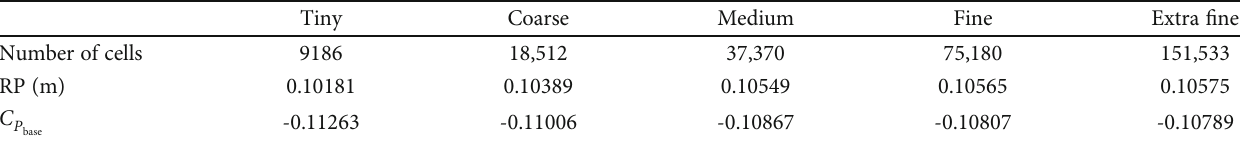
Table 4: Grid sensitivity test (axisymmetric